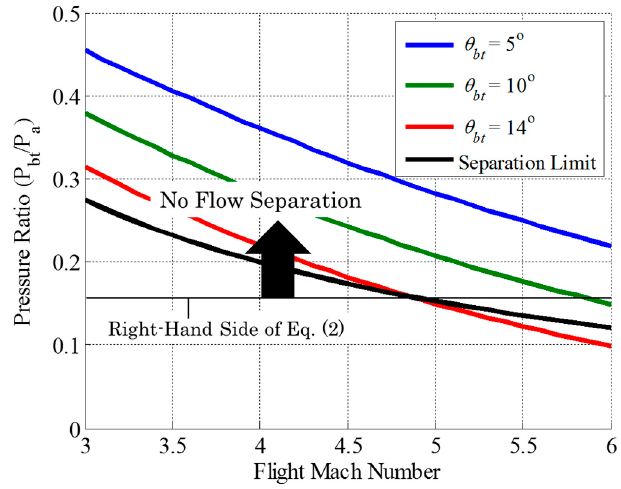
Figure 5. Flow separation limit of external flow on the boattail.